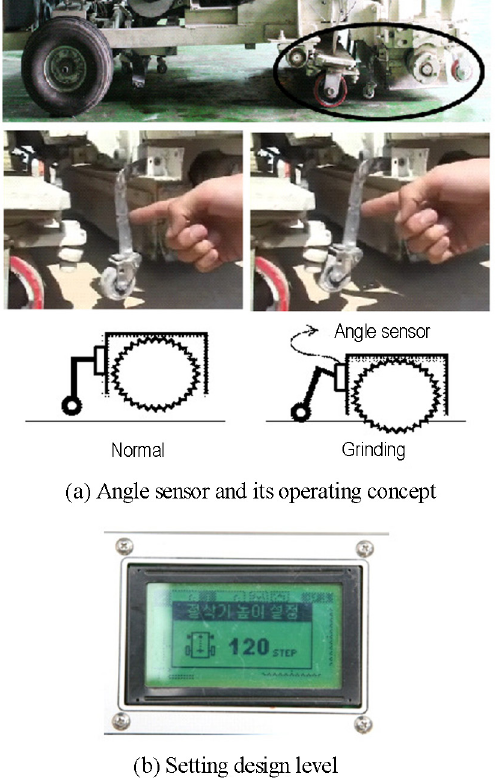
Fig. 7. Angle sensor for quality control